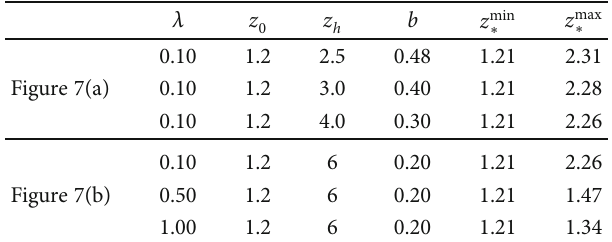
Table 4: Parameter values for fi nite temperature potential